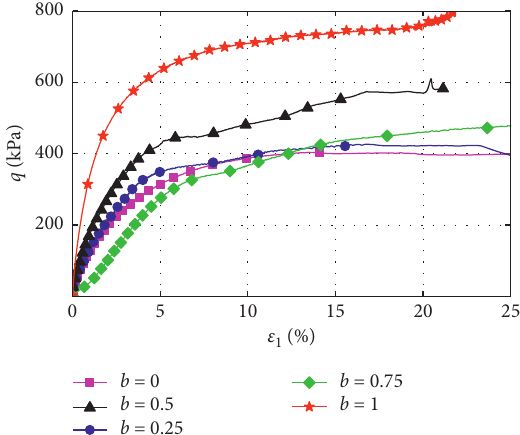
Figure 9: The relationships of q - ε